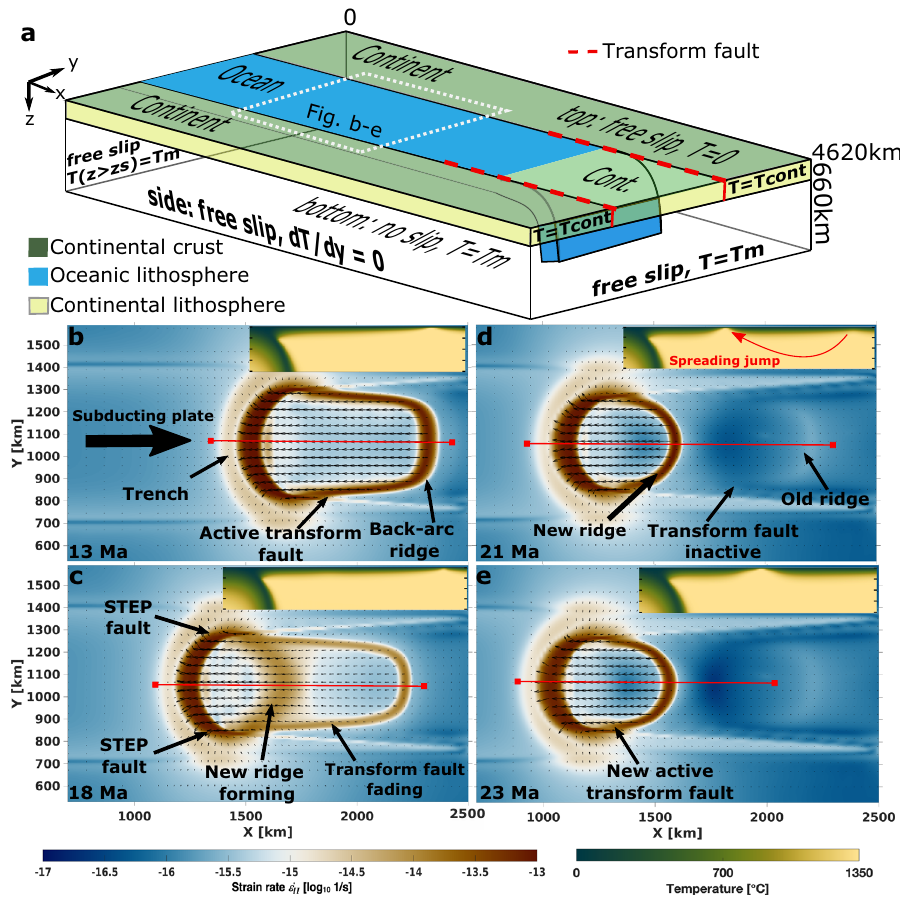
Fig. 2 Model evolution. Model setup ( a ) and evolution ( b – e ) of the second invariant of the strain rate ( _ ε II ¼ slab which is used as reference model. Arrows represent absolute motion with reference to the fi xed model edge. Model evolution plots show an inset area of panel ( a ) of surface strain rate in the centre of the model domain and the vertical-temperature pro fi le up to 200 km depth along the red line. a A narrow slab subducts between two buoyant continents and below an overriding continental plate. The slab is initially placed up to 150 km deep in the mantle and between two prescribed transform faults ending after 660 km in x-direction (dashed red lines) to ensure subduction initiation. b After opening of an initial back-arc basin, transform faults form, connecting the trench and spreading centre. c At a critical distance, increased coupling between back-arc and neighbouring plates forces the transform faults to become inactive and localization of stresses closer to the trench. d A rapid ridge jump occurs. e The slab width is decreased and new transform faults are